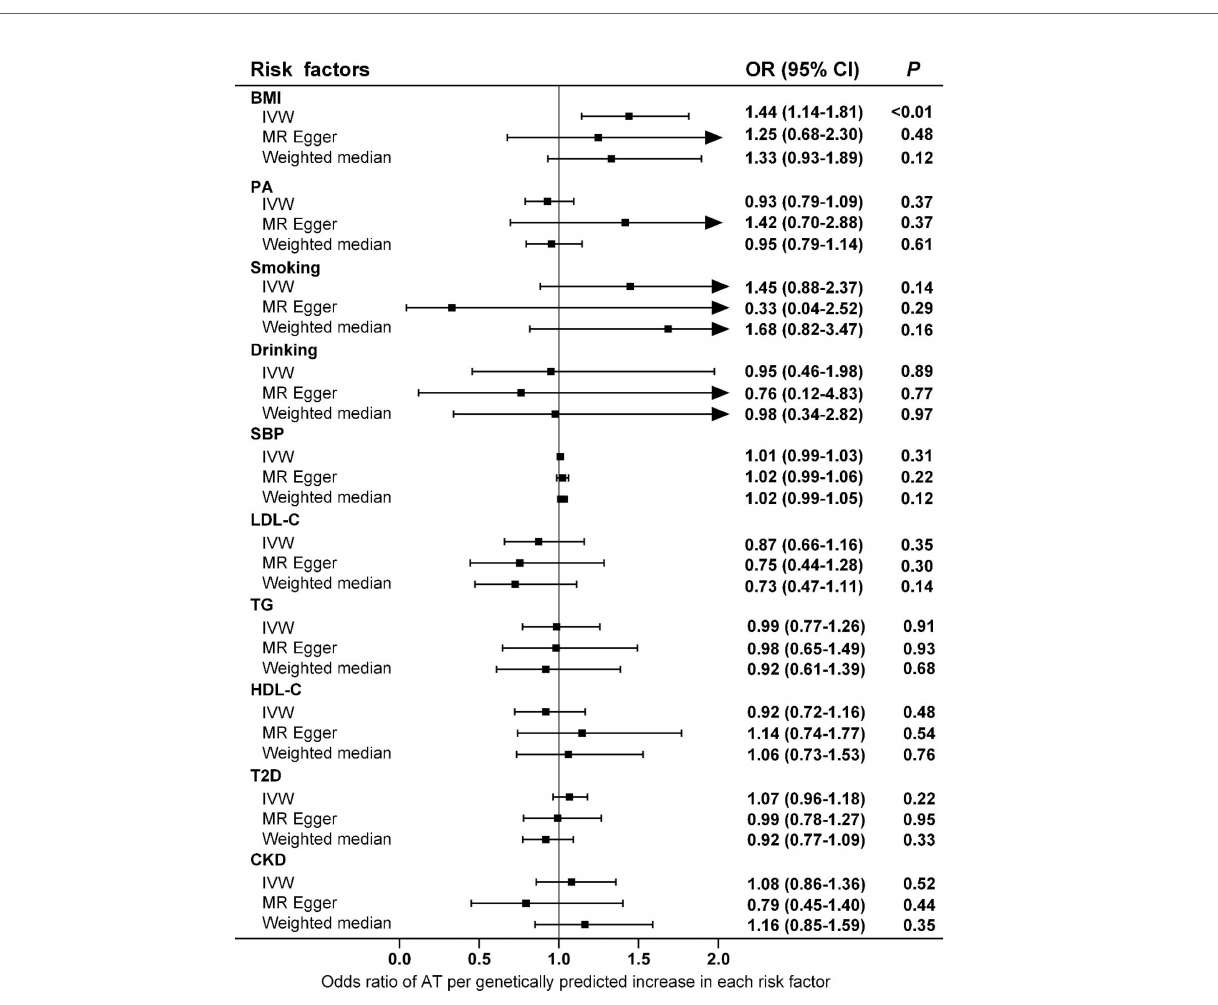
FIGURE 1 | Associations of genetically predicted risk factors with risk of AT as examined by three MR methods. MR, Mendelian Randomization; IVW, inverse- variance weighted; BMI, body mass index; PA, physical activity; SBP, systolic blood pressure; LDL-C, low-density lipoprotein cholesterol; TG, triglyceride; HDL-C, high-density lipoprotein cholesterol; T2D, type 2 diabetes; CKD, chronic kidney disease; AT, Achilles tendinopathy; OR, Odds ratios; CI, con fi dence